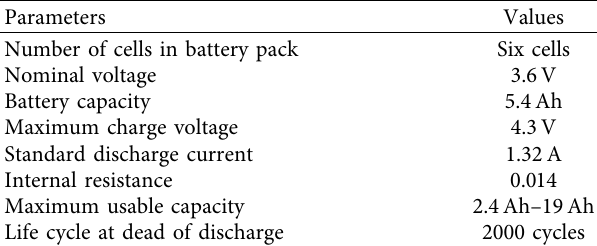
Table 7: Lithium-ion battery pack specifcation.